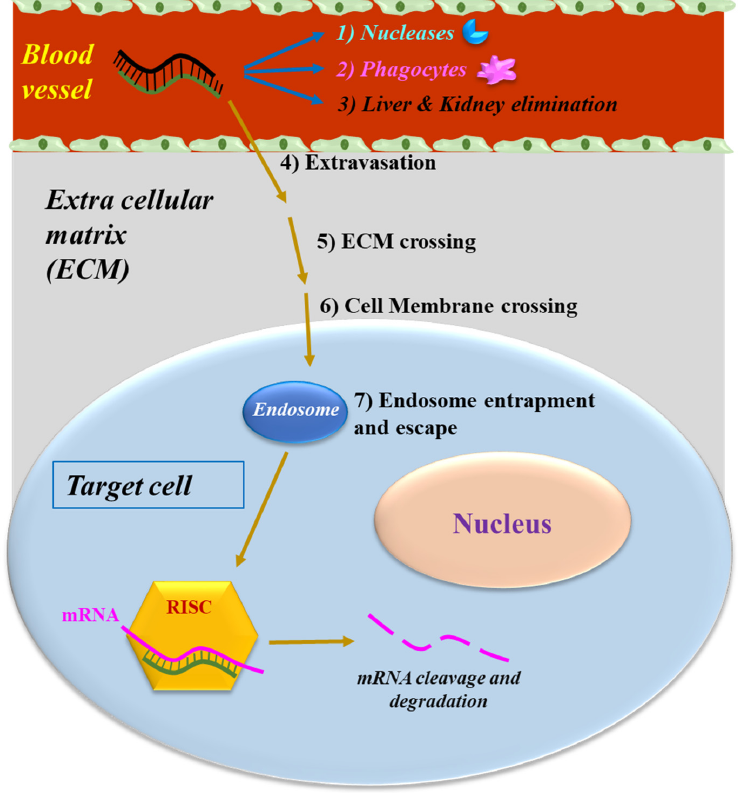
Figure 2. The obstacles to siRNA delivery. Systemically-released siRNAs encounter blood nucleases, which can induce siRNA rapid degradation together with the clearance by phagocytes. Extravasation, cell membrane crossing and endosomal escape are the other barriers to be overcome by siRNAs.